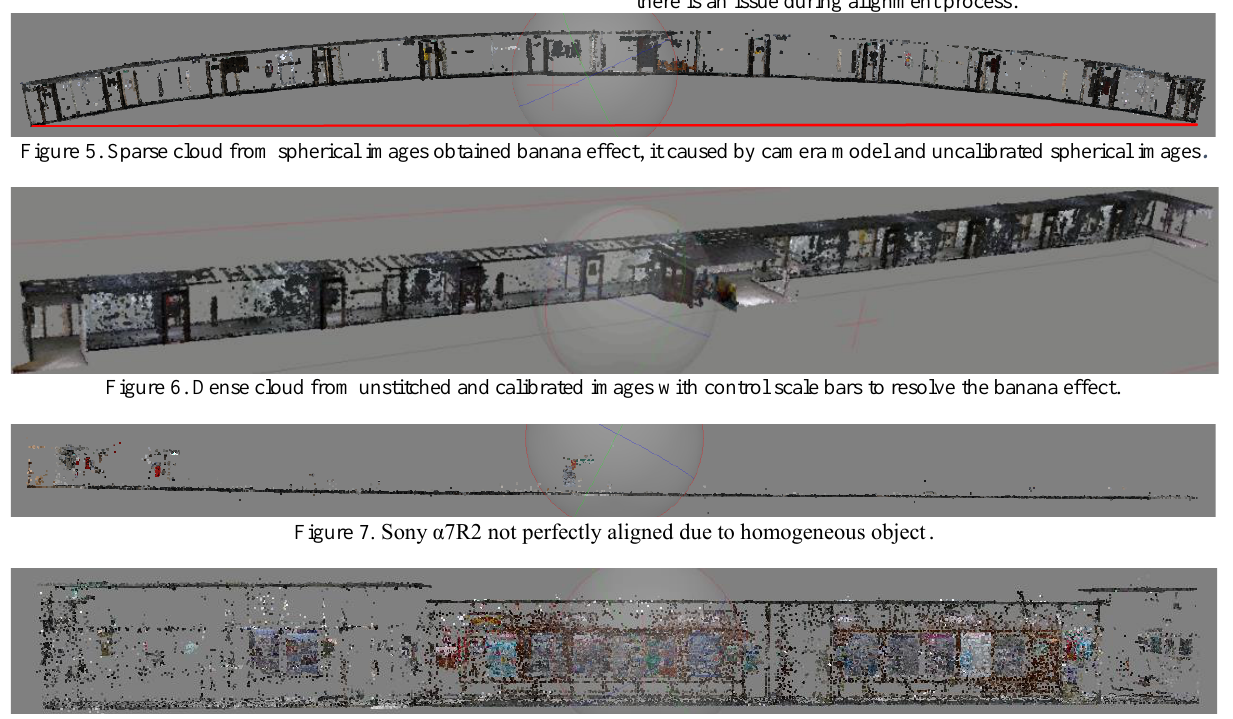
Figure 8. Sony α7R2 is applied to another corridor area with more